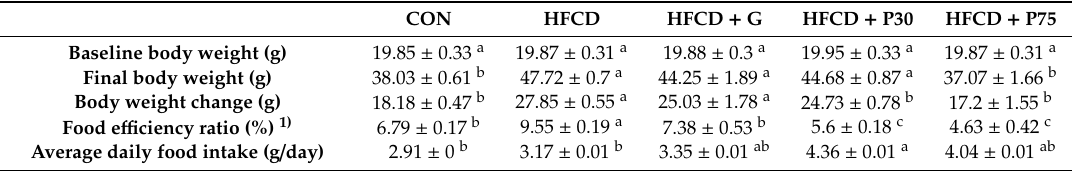
Table 1. E ff ects of phenethyl isothiocyanate (PEITC) supplementation on the body weight and food e ffi